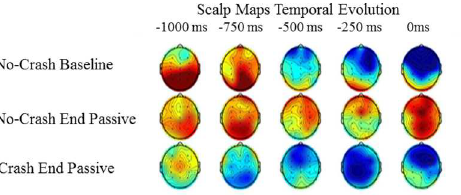
Fig 3. Topographical distribution of temporal evolution of the brain anticipatory activity in the Baseline and the two passive